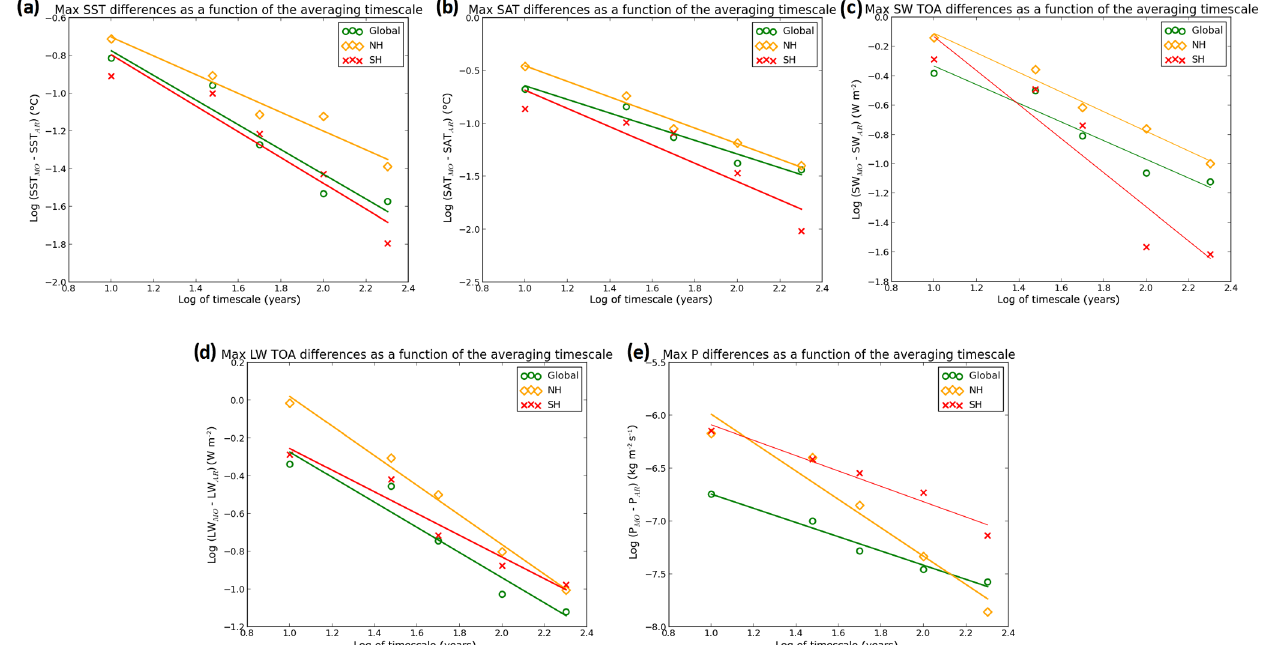
Figure 10. Log–log plots of SST (a) , SAT (b) , SW TOA (c) , LW TOA (d) , and P (e) representing maximum (PI MO − PI AR ) differences as a function of the timescale. All the variables were averaged globally (green circles) and over the SH (red crosses) and NH (yellow diamonds). The straight lines represent the best-fit lines for the data obtained by linear